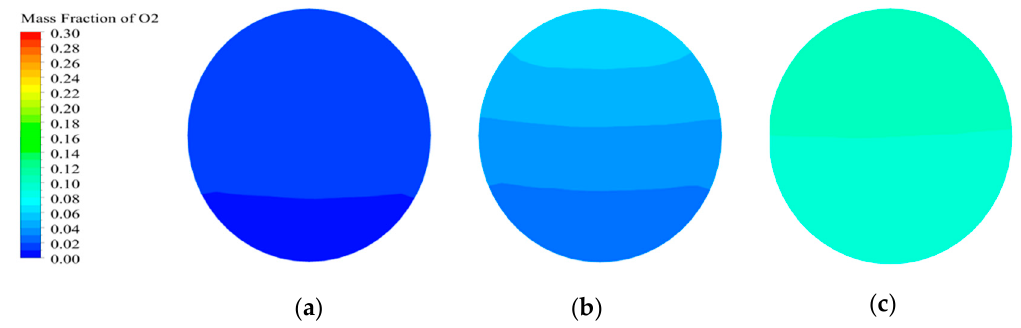
Figure 10. O 2 content distribution nephogram at the outlet with different O 2 ratios: ( a ) 0.1 O 2 , ( b ) 0.2 O 2 , and ( c ) 0.3 O 2 .